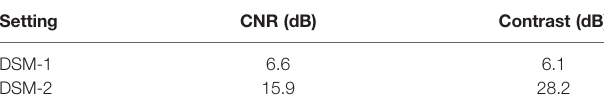
TABLE 1 | Contrast-to-noise ratio (CNR) and contrast ratio (CR) in the US images acquired by the DSM-1 and DSM-2 settings.